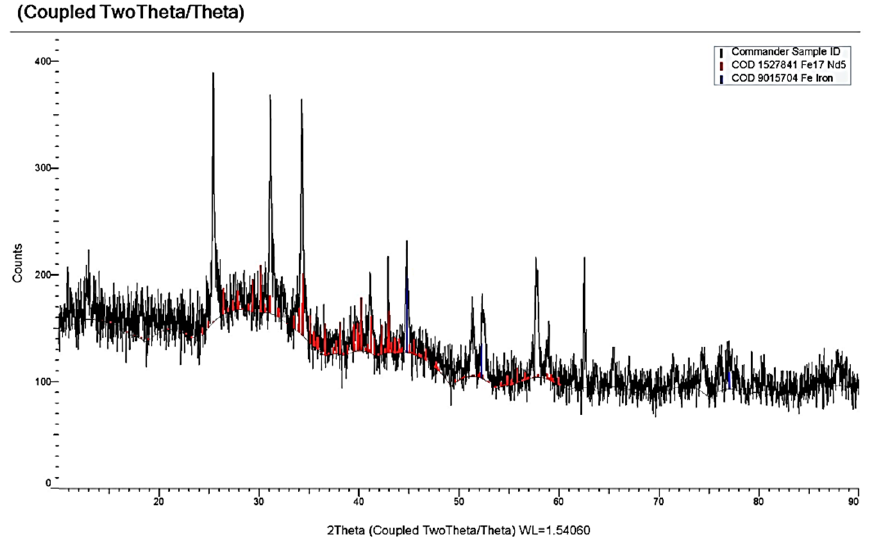
Figure 16. X-ray pattern of the cathode deposit obtained by electrolysis of the KCl-NaCl-NdCl 3 -FeCl 3 melt at 973 K for 1 h and the cell voltage of 2.8 V. Concentration of NdCl 3 is 4.0 × 10 − 4 mol/cm 3 . Concentration of FeCl 3 is 1.0 × 10 − 4 mol/cm 3 .